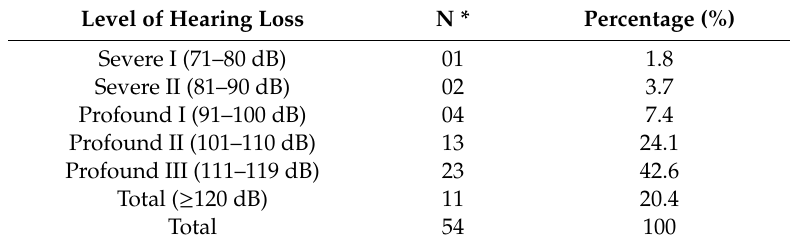
Table 1. Audiometric classification of hearing impairment, according to the Bureau International d’Audiophonologie (BIAP)